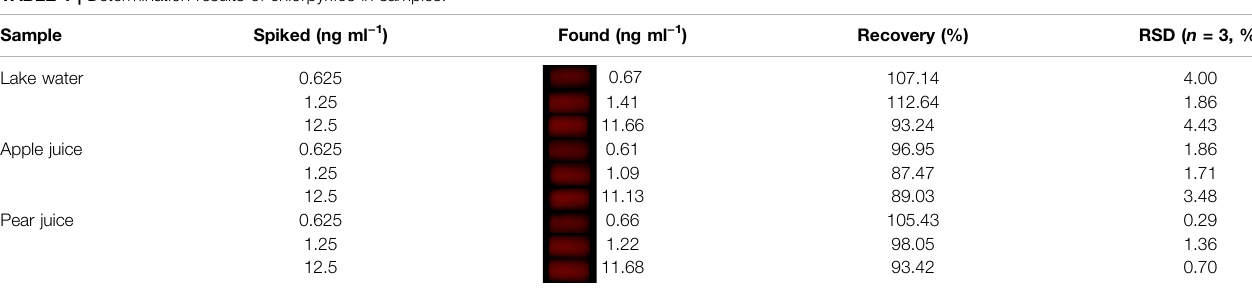
TABLE 1 | Determination results of chlorpyrifos in